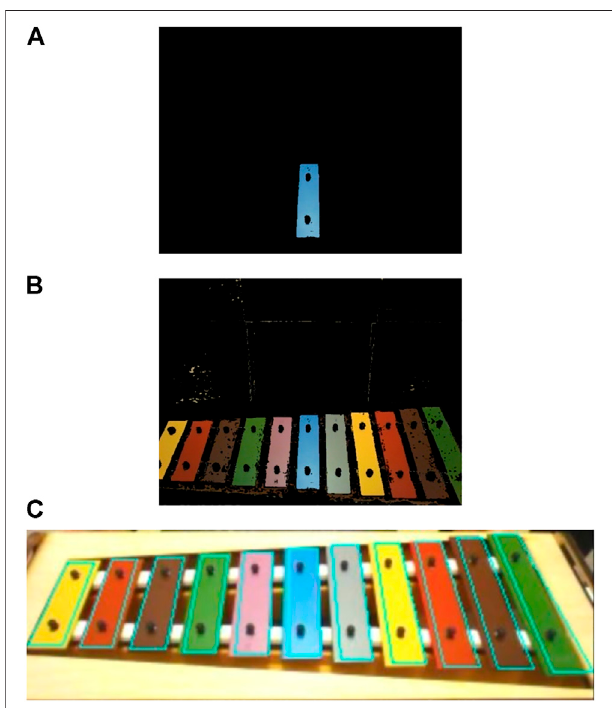
FIGURE 7 | Color detection from NAO ’ s bottom camera: (A) single blue color detection (B) full instrument color detection (C) color based edge